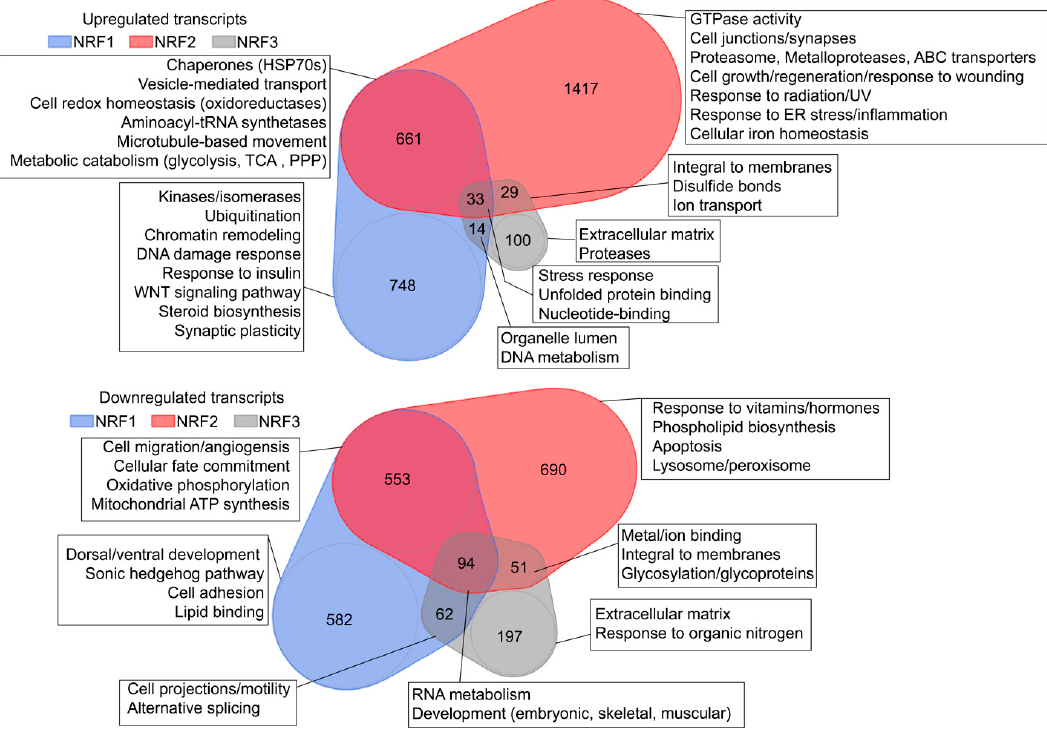
Figure 3. Venn diagrams depicting the number of transcripts upregulated ( top ) or downregulated ( bottom ) in response to overexpression of the indicated NRF transgenes. Boxes depict the results of pathway analyses of the indicated regions of Venn overlap.